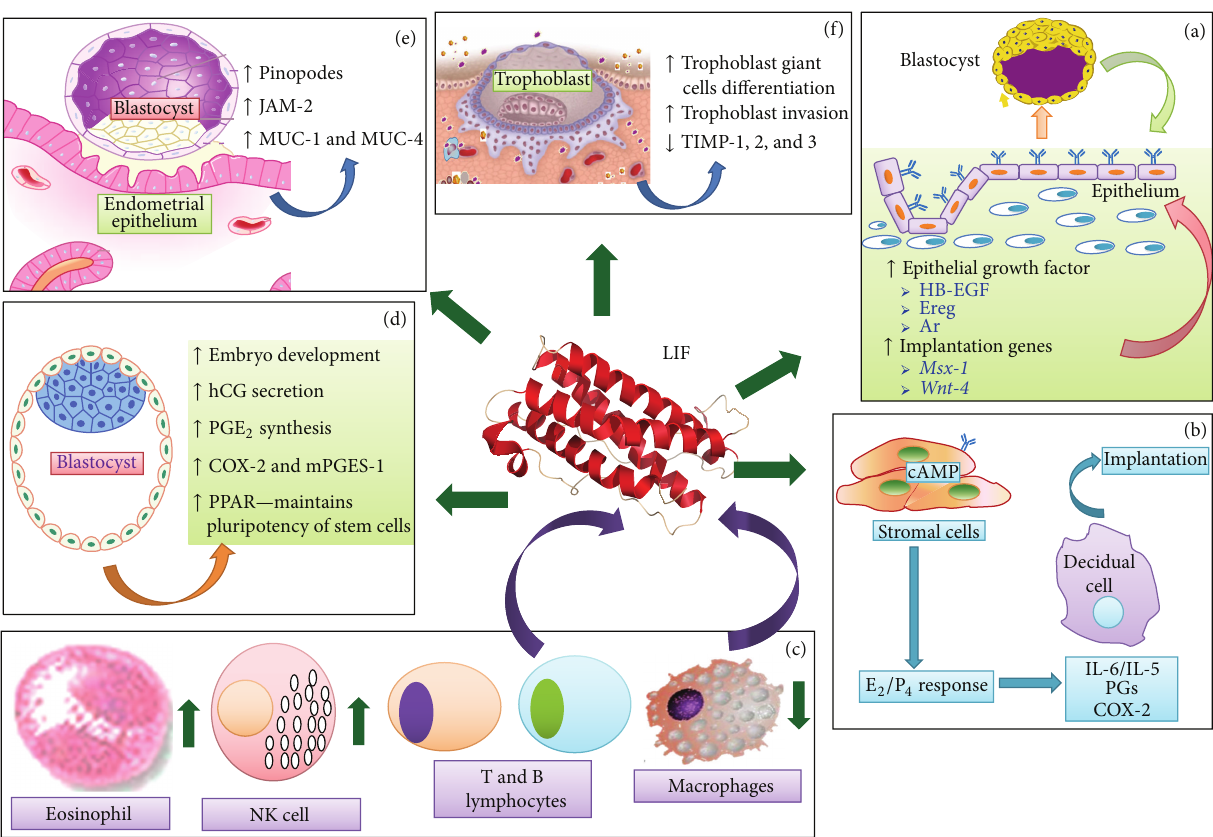
Figure 1: Summary of the known roles of LIF in embryo implantation. LIF increases the expression of EGF and implantation genes in receptive endometrium. LIF produced by endometrium and blastocyst regulates growth and development of the embryo. Meanwhile, LIF stimulates stromal decidualization by increasing the production of cytokines and prostaglandins. LIF is also involved in enhancing embryo-endometrial interaction through pinopodes and adhesion molecules. LIF stimulates trophoblast cells differentiation and increase trophoblast capability to invade the uterine stroma. Finally, LIF is involved in recruitment of specific cohort of leucocytes which participates in inflammatory response during implantation. LIF: leukemia inhibitory factor, HB-EGF: heparin binding-epidermal growth factor, Ereg: epiregulin, Ar: amphiregulin, E2: estrogen, P4: progesterone, IL: interleukins, PGs: prostaglandins, COX: cyclo-oxygenase, NK: natural killer, PPAR: peroxisome proliferator-activated receptor, PGE2: prostaglandins E2, hCG: human chorionic gonadotrophin, MUC: mucin, JAM: junctional adhesion